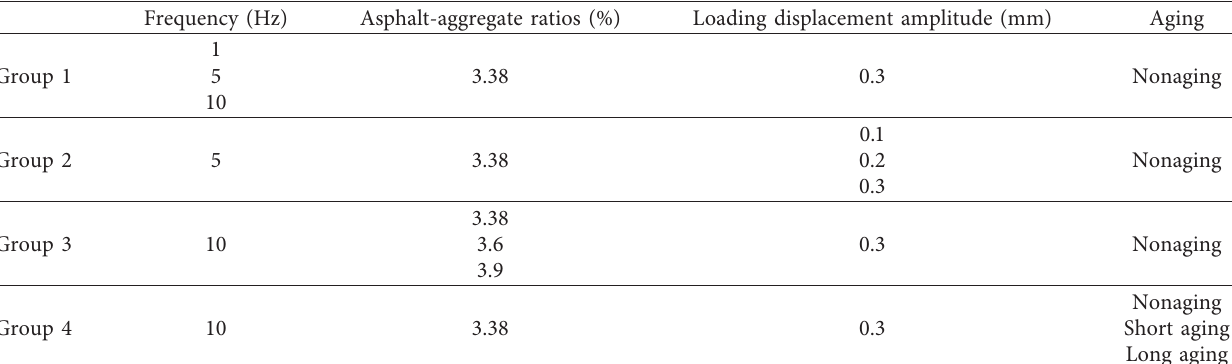
Table 3: The specific test